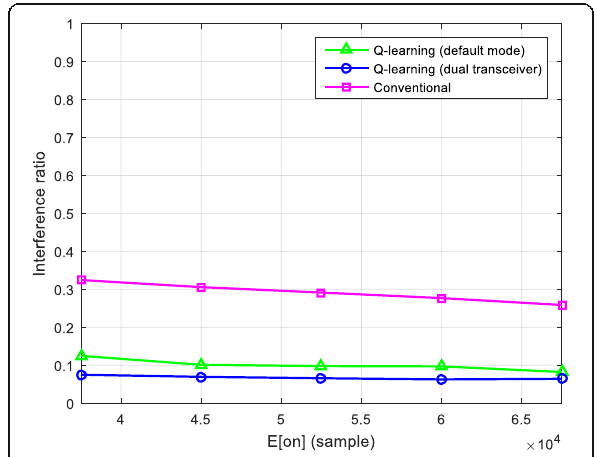
Fig. 17 Interference ratio according to E [on] ratio. Compares the actual interference ratio according to the ratio of E [on] with the proposed method and the general sensing optimization method. If the sensing and transmission intervals are alternating, there is no way to recognize the PU during data transmission. Therefore, even if the idle is detected in the sensing interval, the interference ratio is high because the PU occurs in the data transmission interval. As the E [on] increases, the probability of the PU of the sensing interval continuing to the data transmission interval is high and the interference ratio decreases. Both proposed methods considerably lower the interference ratio than the conventional method, and the second method shows a lower interference ratio because the data transmission is immediately stopped using the narrow band as soon as the PU is detected